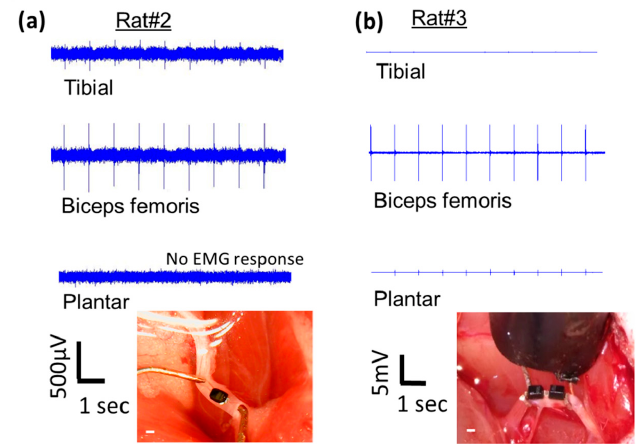
Figure 7. Variable EMG responses from different muscle groups due to ( a ) single, free-floating, SC-79 packaged Skyworks diode stimulated with a high frequency (300 kHz) AC field by platinum hook electrodes and ( b ) two, free-floating SC-79 packaged Skyworks diode stimulated at 1 MHz. The burst repetition rate was 1 Hz for both diode configurations. Relative locations of diodes are shown below the respective EMG responses. Scale bar is 1 mm.